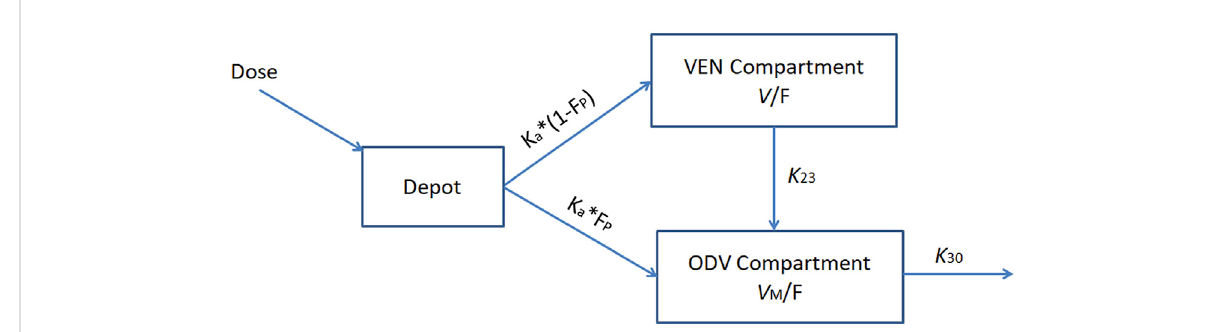
FIGURE 1 Population pharmacokinetic model structure for VEN and ODV. K a , absorption rate constant, K 23 , rate constant for the conversion of VEN into ODV;